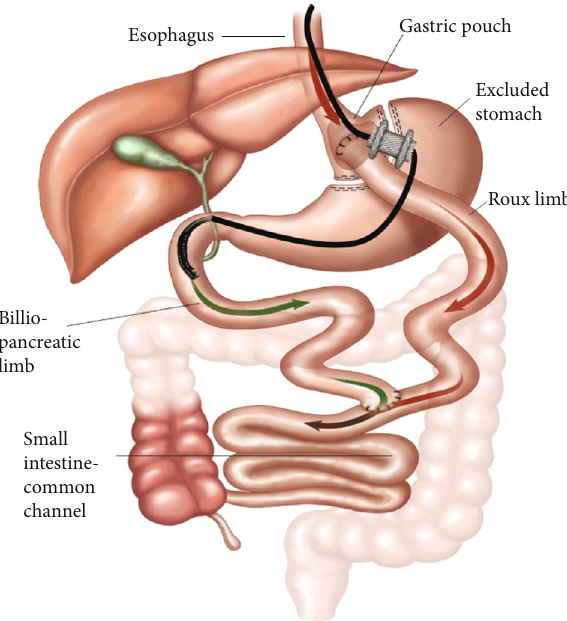
Figure 2: DepictionofEndoscopicUltrasound-DirectedTransgastric ERCP (EDGE procedure). Image provided by Dr. Prashant Kedia.